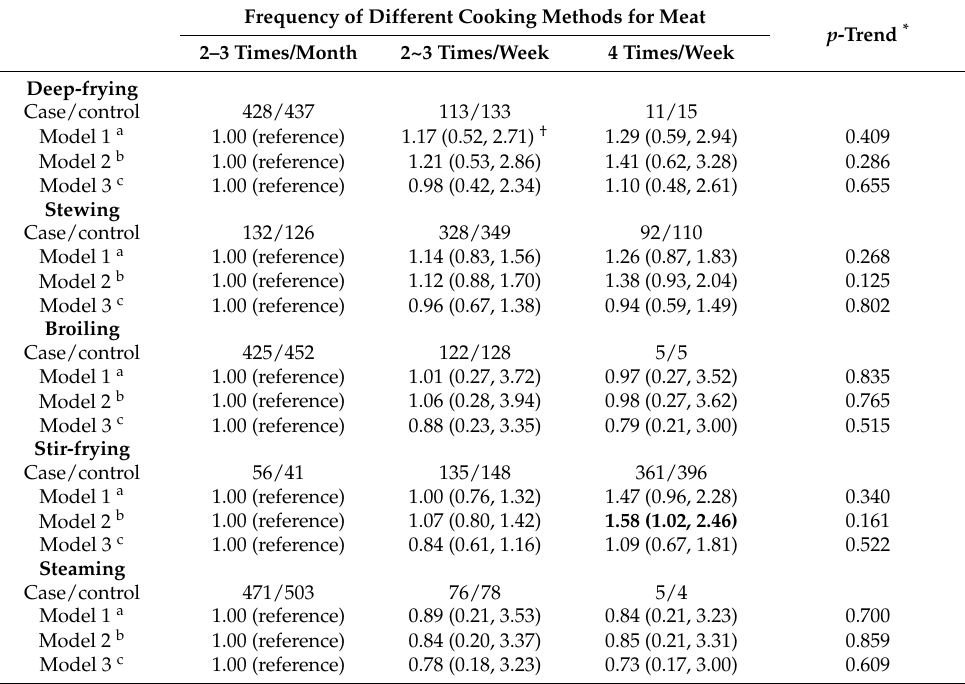
Table 3. Associations between different cooking methods for meat and asthenozoospermia. Frequency of Different Cooking Methods for